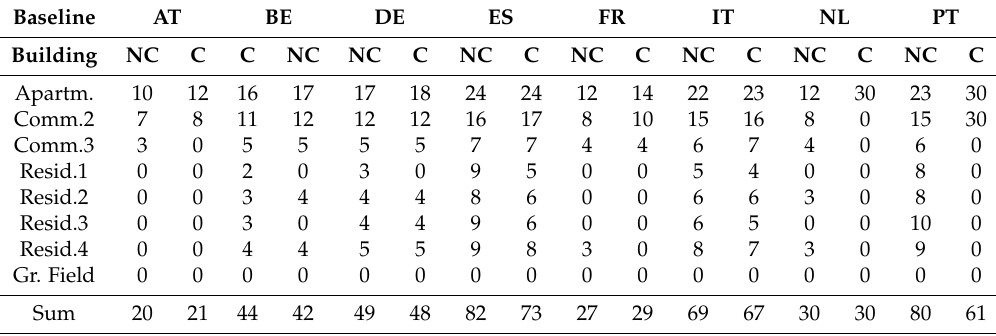
Table 2. Installed PV per building for no commnunity (NC) and community (C), demand scenario baseline, in (kWp), rounded